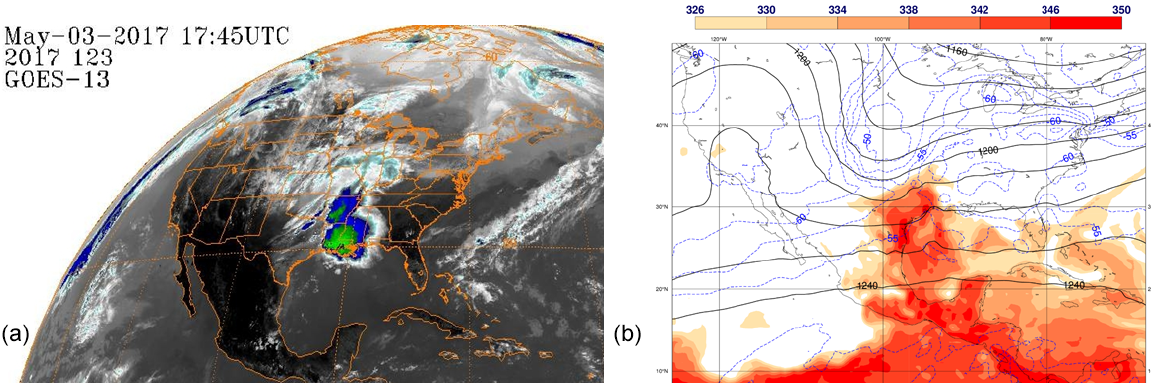
Figure 8. (a) Infrared image of the continental US from the GOES-13 geostationary satellite, valid on 3 May 2017, 17:45UTC (credits: National Centers for Environmental Information, NOAA). (b) ECMWF operational analysis of geopotential at 200hPa (continuous isolines), temperature at 200hPa (dashed isolines) and equivalent potential temperature at 850hPa (shaded, units Kelvin), valid on 3 May 2017, 18:00UTC.